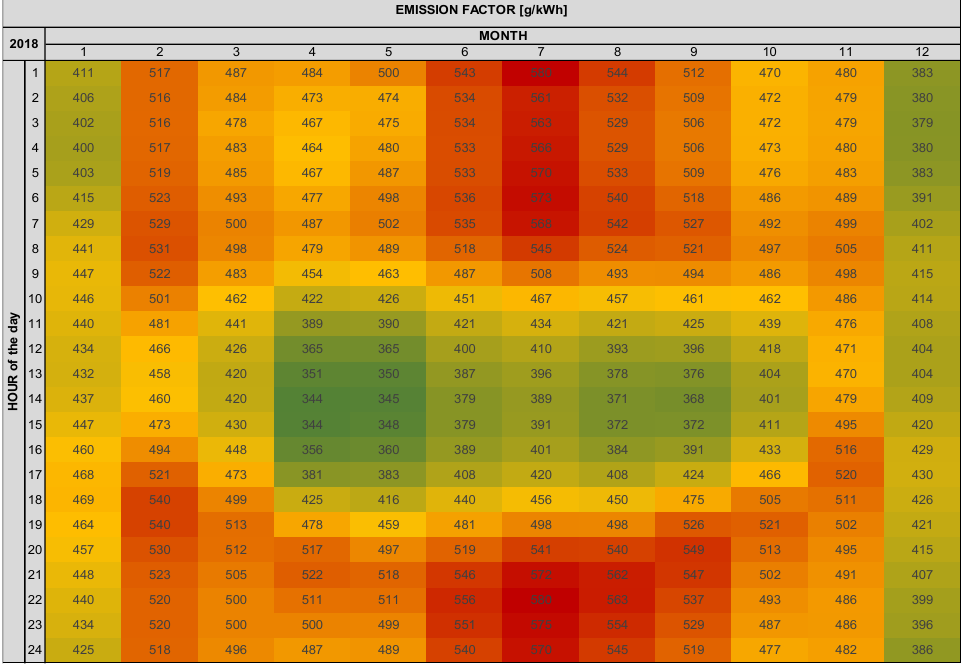
Figure 2. The average value of the emission factor g/kWh for 2018 according to the hours per day and month over the year (own representation, data from [12]).